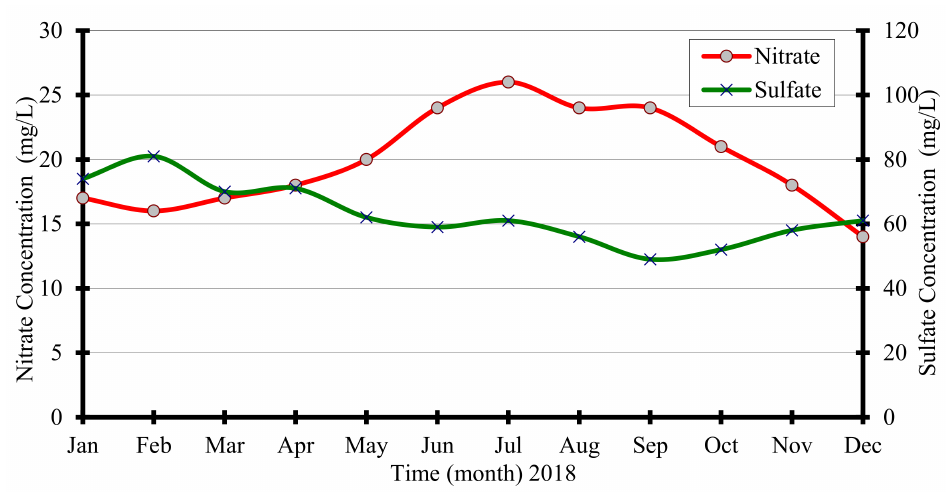
Figure 6. Correlation between nitrate and sulfate in well water using monthly values in